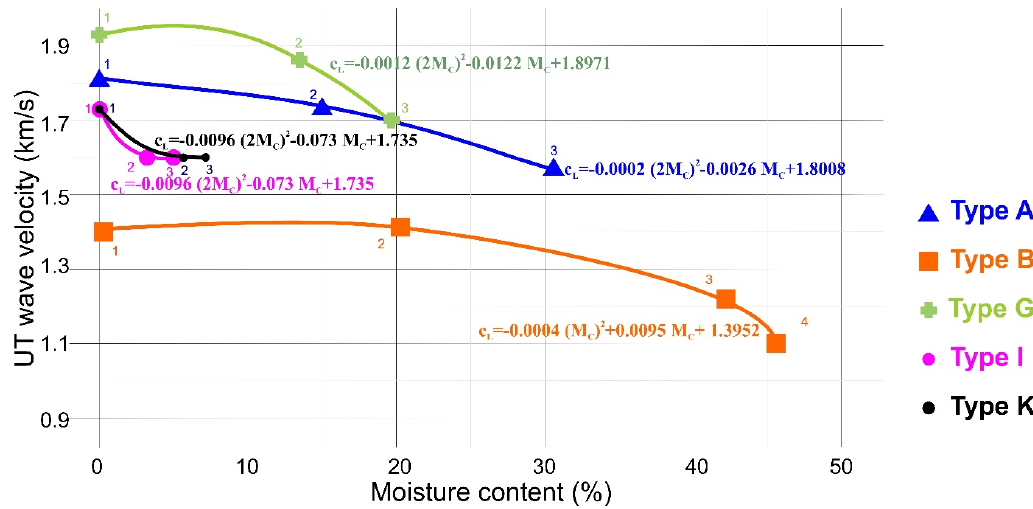
Figure 12. Results of the ultrasound testing (UT) tests. The UT wave velocity was measured in all specimens types before and after the hydration tests. specimens types before and after the hydration